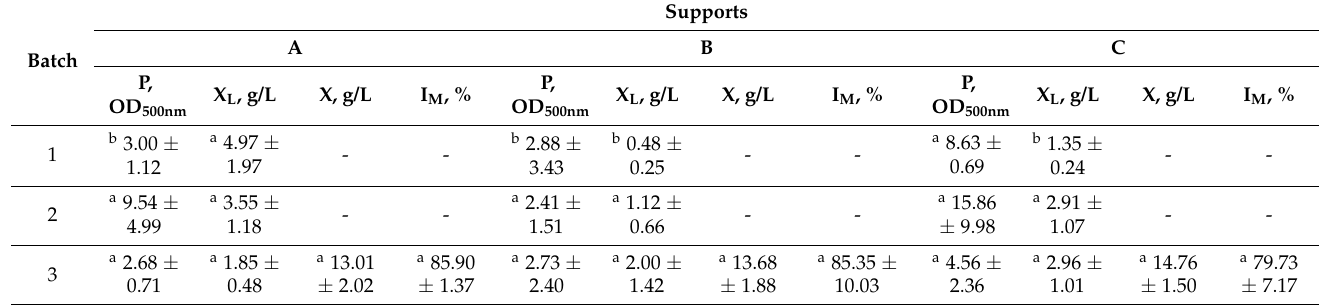
Table 1. Pigment production and total and loosened biomass in three consecutive batches using three different